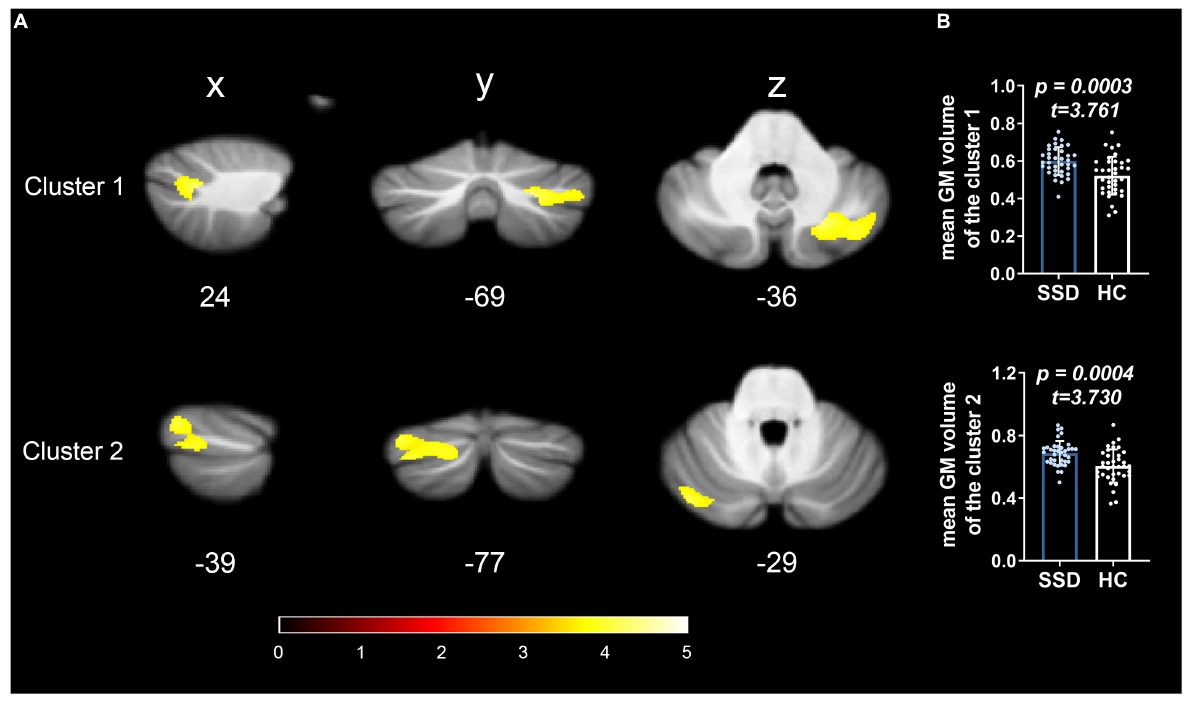
Frontiers in Neuroscience |